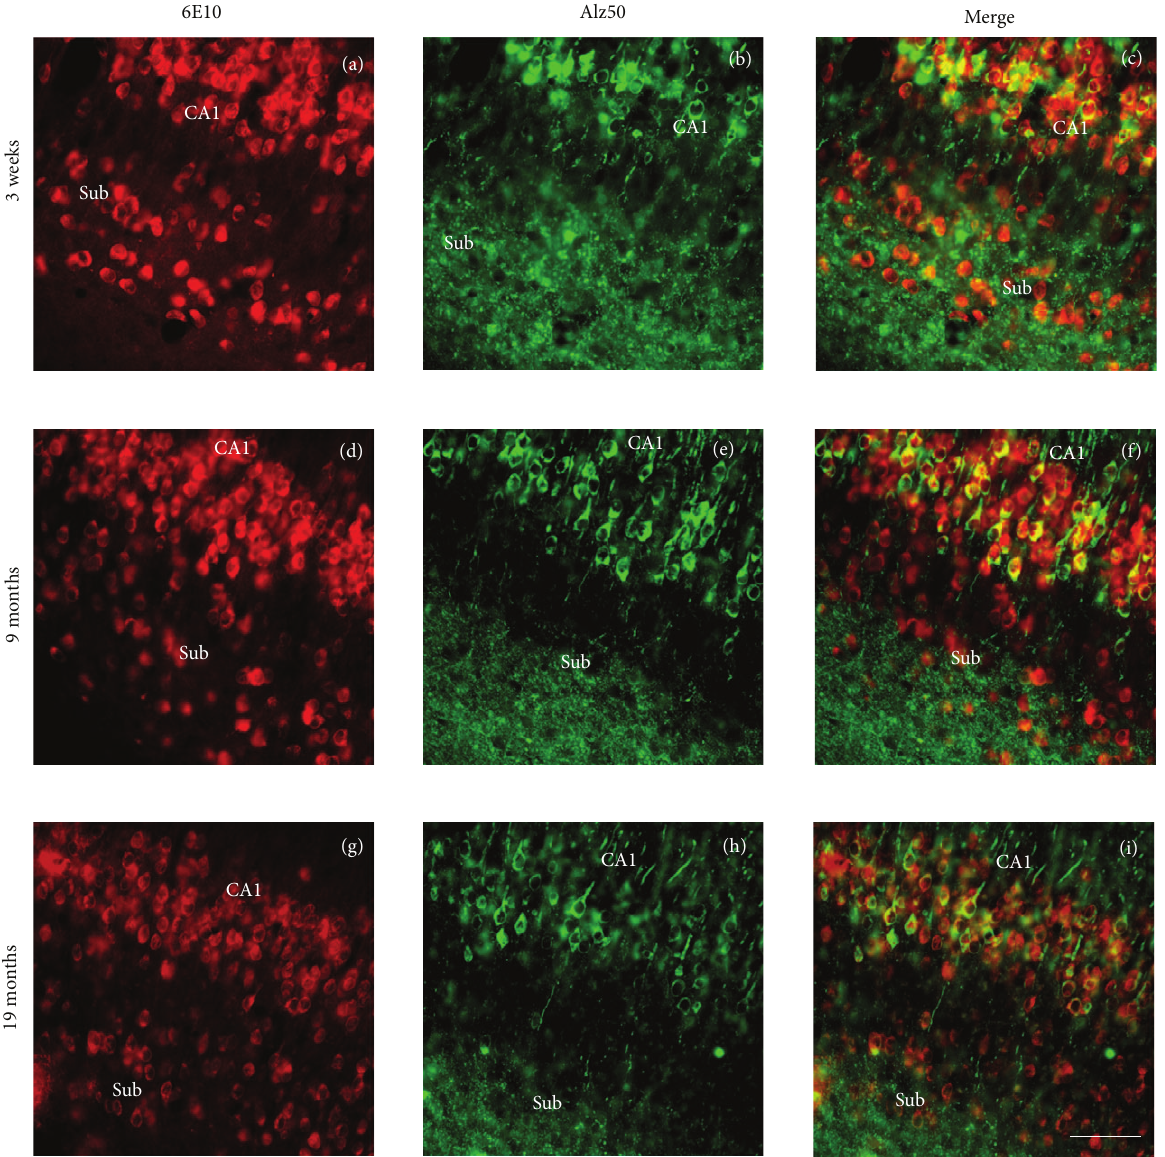
Figure 11: Immunofluorescent microscopic images showing single and dual 6E10 and Alz 50 staining in the hippocampal CA1 field and the subiculum of 3xTg-AD mice. Images of single 6E10 immunolabeled ((a), (d), and (g), red), (b), (e), (h) (Alz50, green) and merged (yellow, (c), (f), (i)) neurons at 3-week, 9- and 19-month-old 3xTg-AD mice. Note that 6E10 immunolabeled neurons are found in both the CA1 and subiculum but only Alz50 immunolabeled neurons were seen in CA1 at each age examined. The merged images show that many CA1 neurons contained both 6E10 and Alz50 immunoreactivity whereas the subicular neurons were only 6E10 positive at each age examined within Alz50-ir neuropil. Scale bar for (a)–(i) = 75 μ